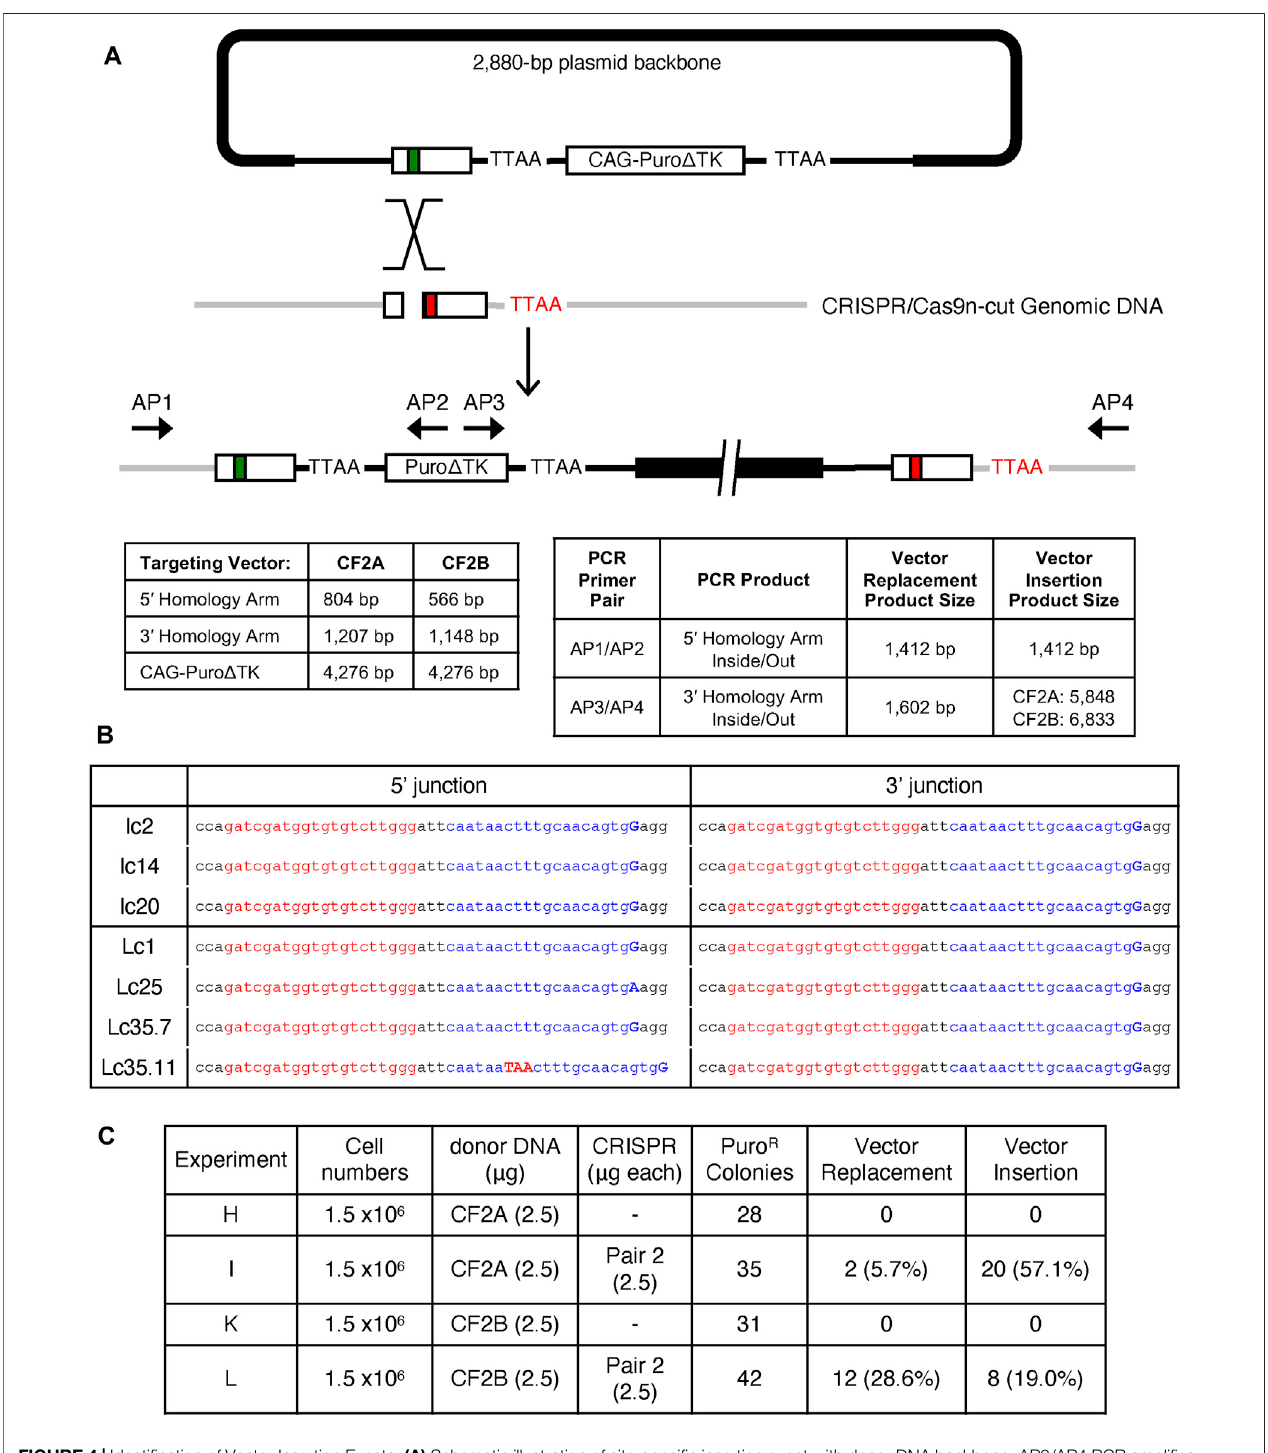
FIGURE 4 | Identi fi cation of Vector Insertion Events. (A) Schematic illustration of site-speci fi c insertion event with donor DNA backbone. AP3/AP4 PCR ampli fi es 5,848-bp product from CF2A donor transfection and 6,833-bp product from CF2B donor transfection, which are con fi rmed in Figure 2D , and Supplemental materials: Supplementary Figure S3 . (B) Representative sequence alignments at 5 ′ and 3 ′ junctions as the consequence of each donor DNA insertion, CF2A (I) or CF2B (L) donor.Lc35cloneinitiallyisolatedwasamixedpopulationofLc35.7andLc35.11cells.Targetingsequencesofpair2gRNAareshowninredandblue.Adenine(A) and Guanine (G) capitalized and representing W1282X mutation (G > A) and the correction (A > G), respectively. (C) Comparison of frequencies between site-speci fi c vectorreplacementandinsertionevents.ThefrequencyofeacheventwascalculatedwiththenumberofpositiveclonesoutofthenumberofpickedandanalyzedPuro R